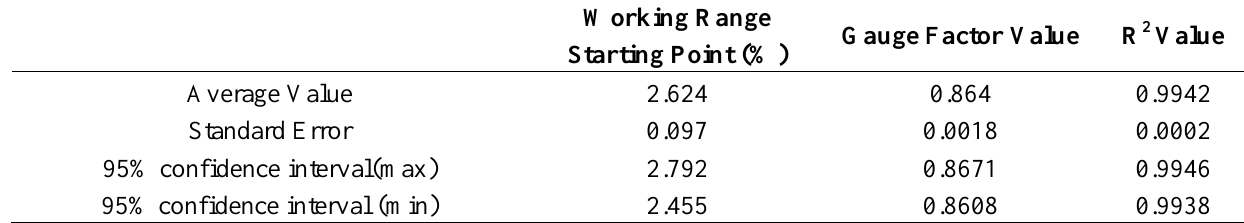
Table 4. Statistical results of Type 2 sensor.